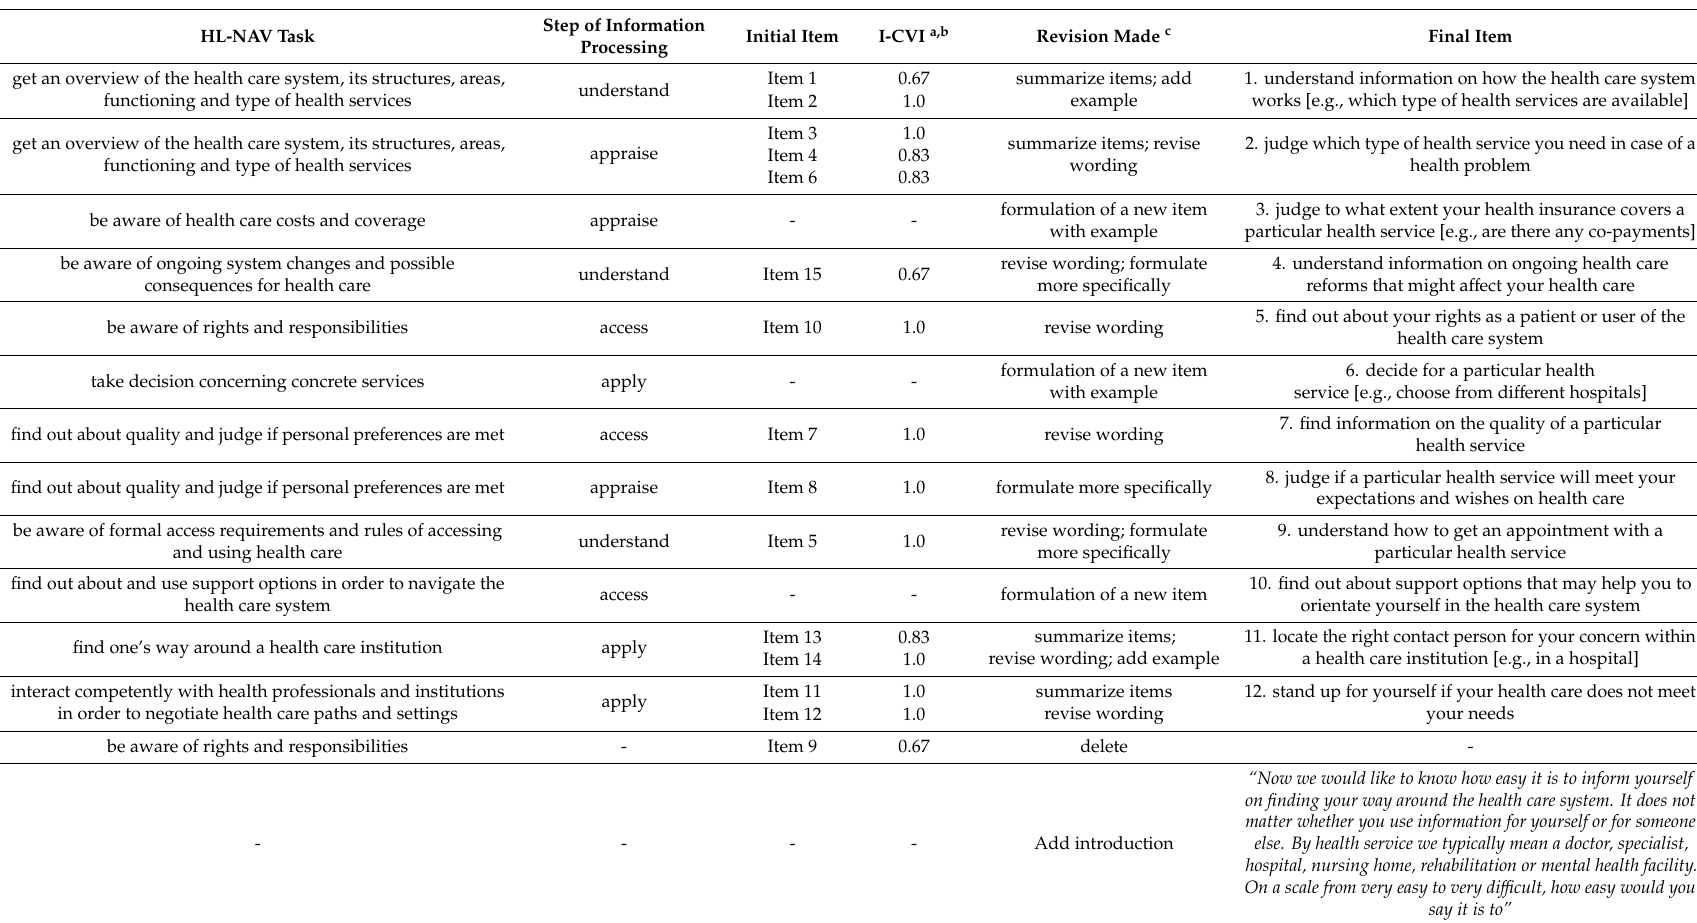
Table 3. Final items classified by tasks and steps of information processing, I-CVI for initial Items and revision made. HL-NAV